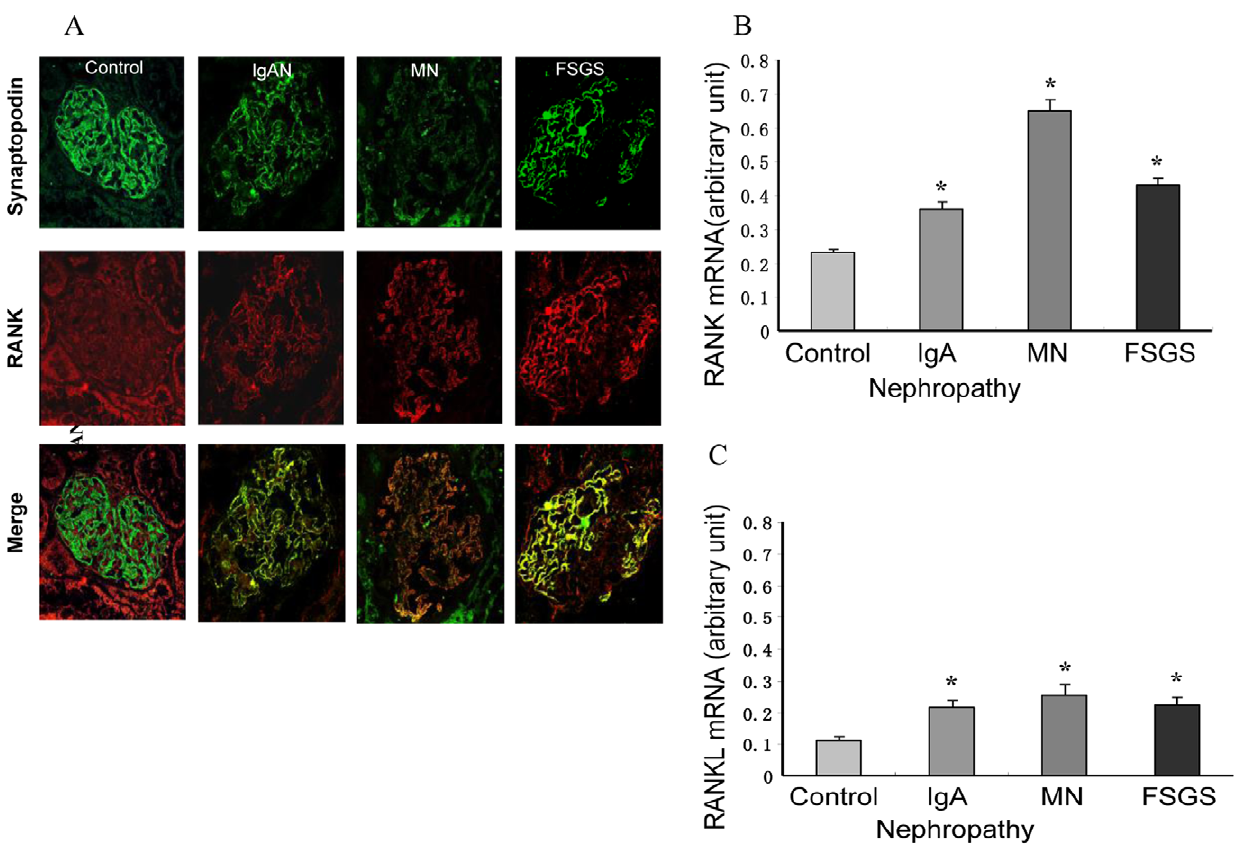
Figure 2. Expression of RANK and RANKL in Human Podocyte Injury Diseases. (A) RANK protein (red) was expressed in glomeruli of human kidney. RANK was found in podocytes, as shown by double immunofluorescence with the podocyte marker synaptopodin (green) resulting in yellow overlap (Merge). Compared with control, immunofluorescence staining for RANK was increased in IgA nephropathy, MN and FSGS, double immunofluorescence staining revealed that the increase in RANK protein expression was mainly attributed to podocytes. There was no immunfluoresence in the glomerulosclerosis position of FSGS. (B) RANK mRNA was expressed in human kidneys. Quantitative real-time RT-PCR was performed on kidney tissue from human biopsies. RANK mRNA was low in individuals without glomerular disease. By contrast, individuals with biopsy-proven FSGS, IgA nephropathy and MN had a significant increase in RANK expression (FSGS 0.42 6 0.07, IgA nephropathy 0.37 6 0.10, MN 0.67 6 0.24, versus control 0.24 6 0.04). *Compared with control, p , 0.01. (C) Quantitative real-time RT-PCR was performed on kidney tissue from human biopsies. RANKL mRNA was low in individuals without glomerular disease. By contrast, individuals with FSGS, IgA nephropathy and MN had a moderate increase in RANKL expression (FSGS 0.25 6 0.07, IgA nephropathy 0.22 6 0.08, MN 0.27 6 0.08, versus control 0.11 6 0.05). *Compared with control, p , 0.01.